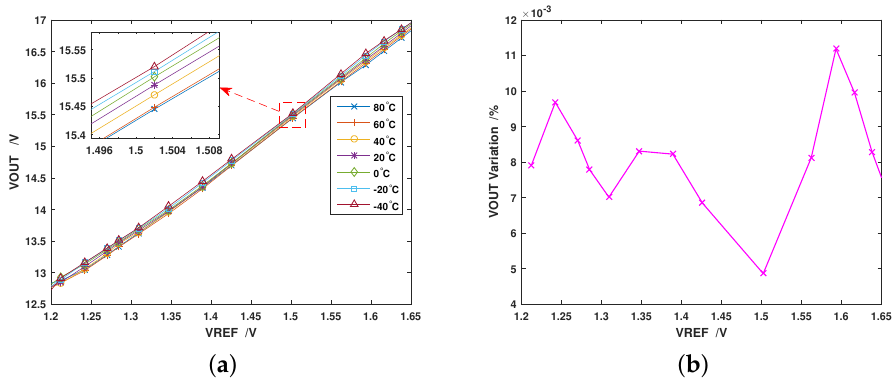
Figure 9. Measured output of the charge pump under different temperature conditions: ( a ) the tested graph of output vs. reference voltage in the linear interval; and ( b ) the maximum variation of the output voltage from − 40 ◦ C to 80 ◦ C.